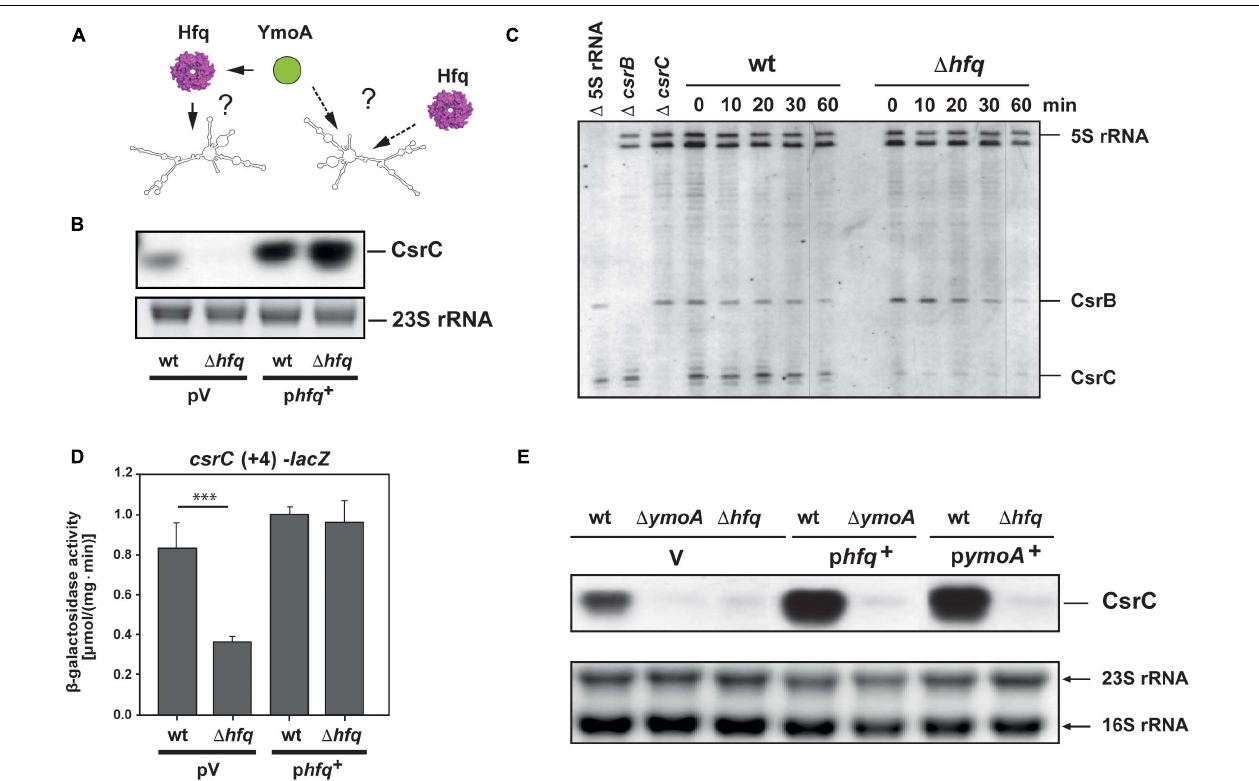
FIGURE 6 | Hfq influence on CsrB and CsrC stability and cooperation with YmoA. (A) The model illustrates possible influence of YmoA on CsrC abundance via or independent of Hfq. (B) Y. pseudotuberculosis strain YPIII (wt) and YP80 ( (cid:49) hfq ) carrying the vector pAKH85 (pV) or its hfq + derivative (pAKH115) were grown overnight in LB medium. Total RNA of the samples was isolated, separated on agarose gels and the CsrC RNA was detected by Northern blotting using a CsrC-specific probe. The 23S rRNAs is shown as RNA loading control. (C) Y. pseudotuberculosis strain YPIII (wt) and YP80 ( (cid:49) hfq ) were grown in LB at 25 ◦ C to early stationary phase, rifampicin was added in a final concentration of 500 µ g ml − 1 and aliquots were withdrawn at indicated time points. Total RNA was extracted and used for primer extension analysis. Samples without addition of labeled primers for 5S rRNA ( (cid:49) 5S rRNA), csrB ( (cid:49) csrB ), and CsrC ( (cid:49) csrC ) were used as controls. The reaction products were separated on 4% DNA sequencing gels. The positions of the transcripts are indicated. (D) Y. pseudotuberculosis strain YPIII (wt) and YP80 ( (cid:49) hfq ) carrying the vector pAKH85 (pV) or its hfq + derivative (pAKH115) and the csrC-lacZ fusion (pAKH103) were grown in LB at 25 ◦ C overnight. β -Galactosidase activity of the cultures was determined (upper panels) and is given in µ mol min − 1 mg − 1 for comparison. The data represent the average ± SD from at least three different experiments each done in duplicate. The statistical significances between the wild-type and the ymoA mutant were determined by the ANOVA test. P -values: ∗∗∗ : < 0.001. (E) Y. pseudotuberculosis strains YPIII, YP50 ( (cid:49) ymoA ) and YP80 ( (cid:49) hfq ) harboring vector pHSG575 (V), a ymoA + (pKB4) or hfq + derivative (pAKH119) were cultivated overnight in LB medium at 25 ◦ C. Total RNA of the strains was prepared, separated on agarose gels and a specific probe was used to detect the CsrC RNAs by Northern blotting. The 16S and 23S rRNAs are shown as RNA loading